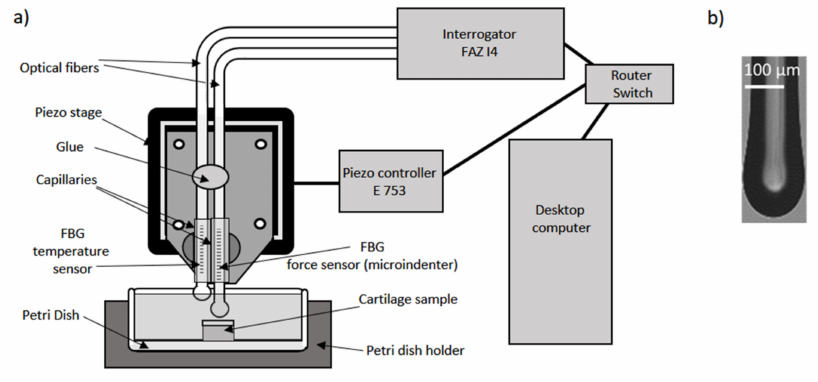
Figure 7. ( a ) Schematic setup used for measuring the stress-relaxation of the cartilage samples. ( b ) Microscope image of the FBG micro-indenter